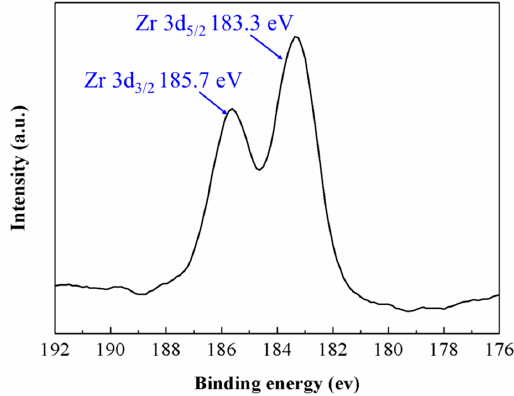
Figure 5. The XPS spectra of the residual ZrO 2 -NPs on the worn a-C surface.